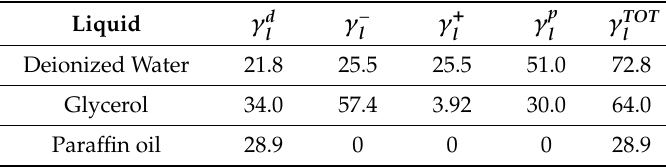
Figure A1. Force-distance trace and retrace of a PF-QNM nanoindentation in a PTT sample before being irradiated. The characteristics of the curve from which the different nanomechanical properties are obtained have been pointed out. Table A1. Surface energy components of sample liquids (mJ/m 2 ) [57].